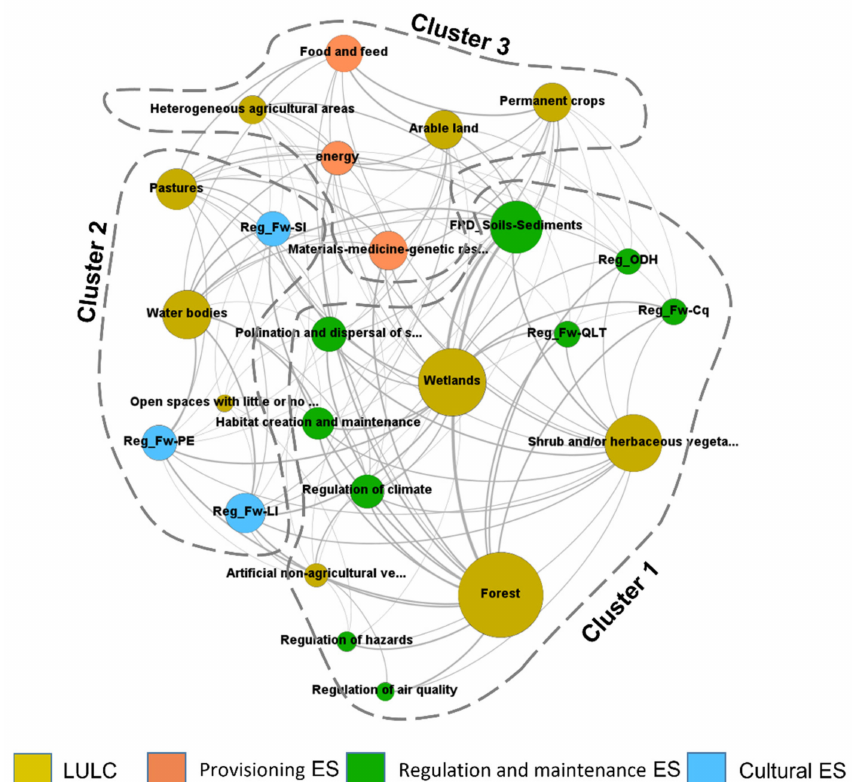
Figure 9. Conformation of clusters between LULC and